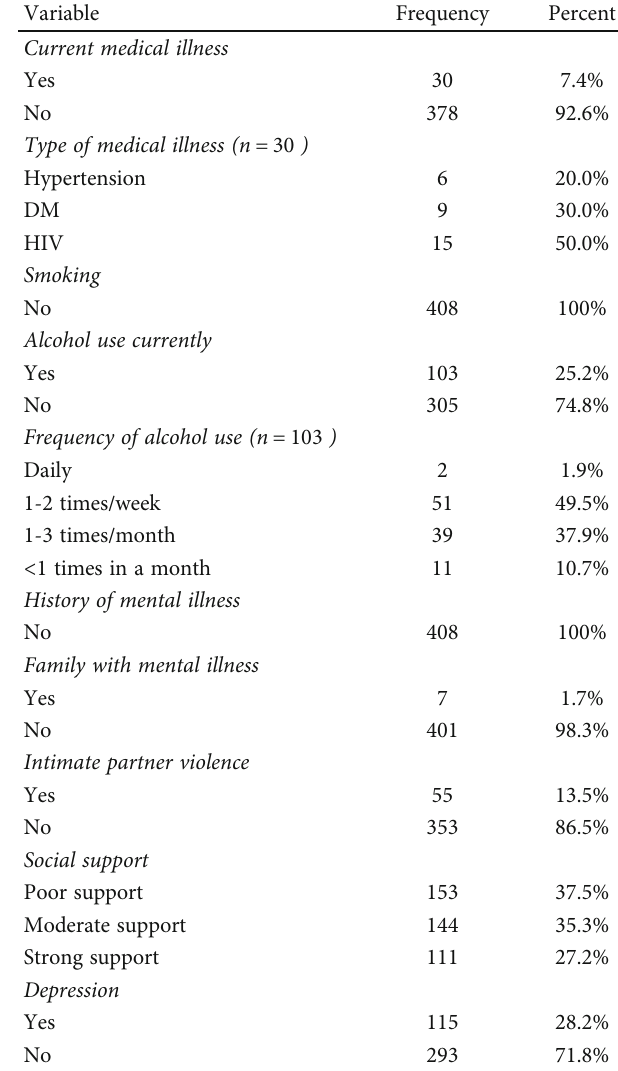
Table 3: Medical, behavioral, and psychosocial characteristics of women attending antenatal care at Debre Markos town public health institutions, Northwest Ethiopia, 2021 ( n = 408